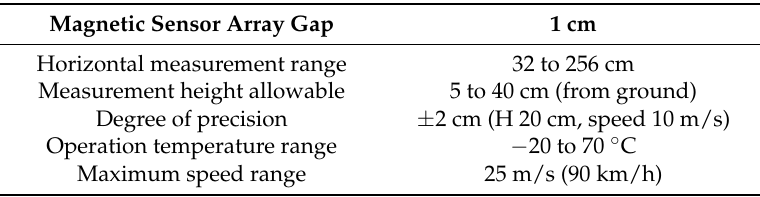
Table 2. Specifications of the magnetic ruler [21].